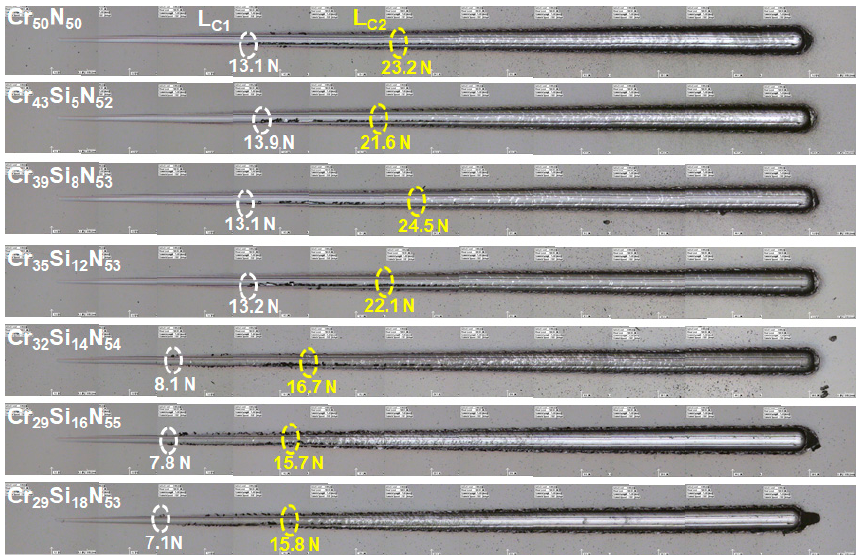
Figure 7. Optical micrograph of the scratch tracks of Cr–Si–N coatings with various Si contents prepared on stainless steel substrates.